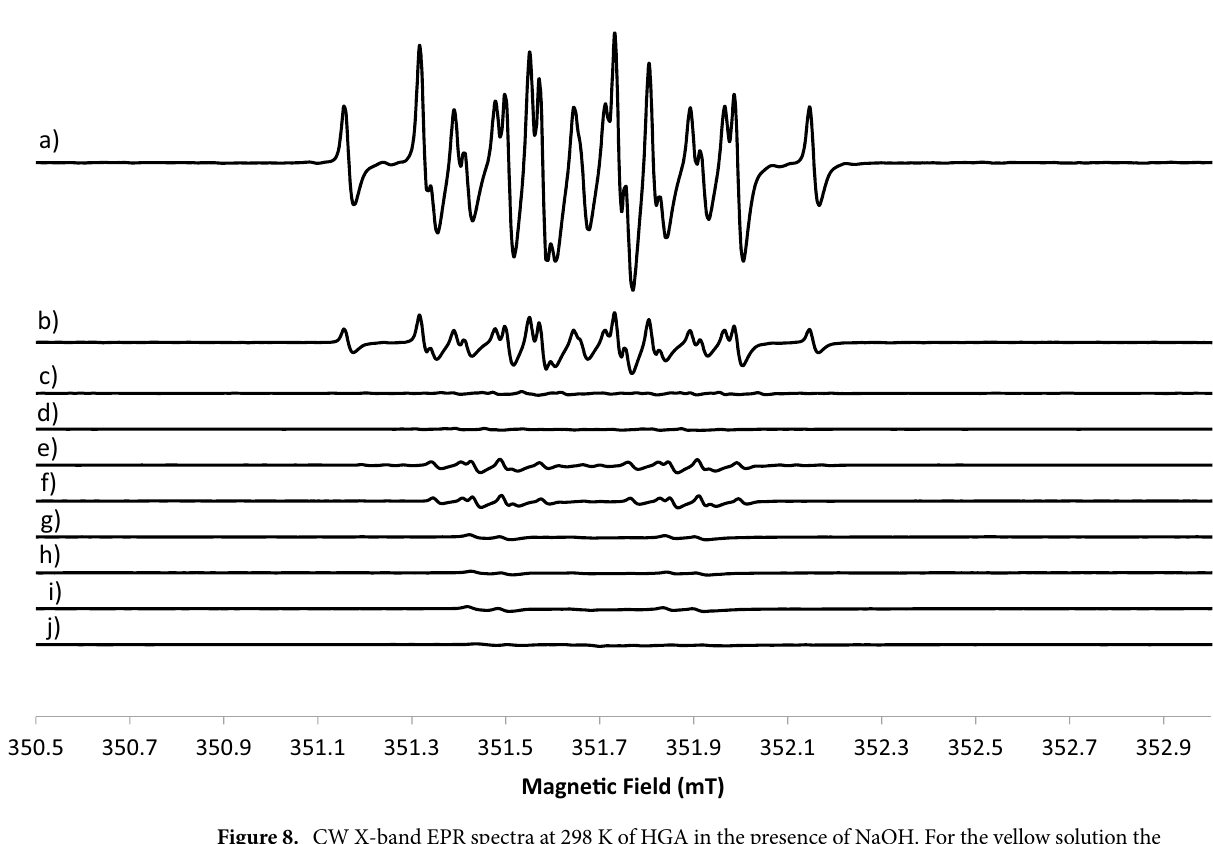
Figure 8. CW X-band EPR spectra at 298 K of HGA in the presence of NaOH. For the yellow solution the acquisition times are: ( a ) t = 0, ( b ) t = 5 min, ( c ) t = 20 min, ( d ) t = 4 h. For the brown solution the acquisition times are ( e ) t = 0, ( f ) t = 20 min, ( g ) t = 1 h. For the black solution the acquisition times are ( h ) t = 40 min, ( i ) t = 75 min, ( j ) t = 4